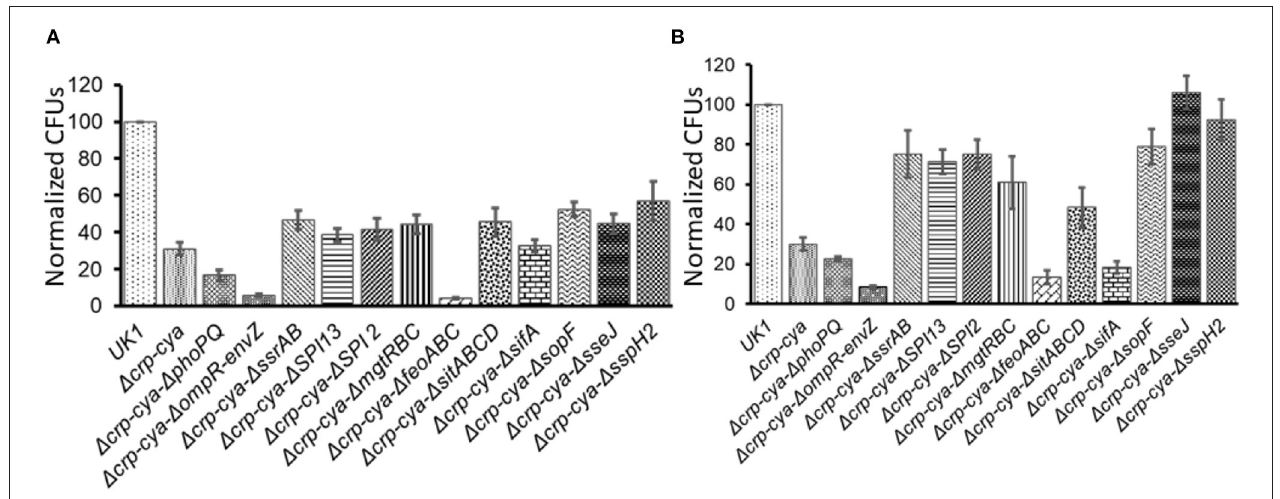
FIGURE 5 | Invasion (A) and intra-macrophage survival (B) of S. Typhimurium UK1, the 1 crp - cya mutant and its derivatives in HD11 macrophage cells. Normalized CFUs of recovered Salmonella strains after 2h (A) and 24h (B) post-infection. Error bars represent the mean ± SD (standard deviation) of three replicates.